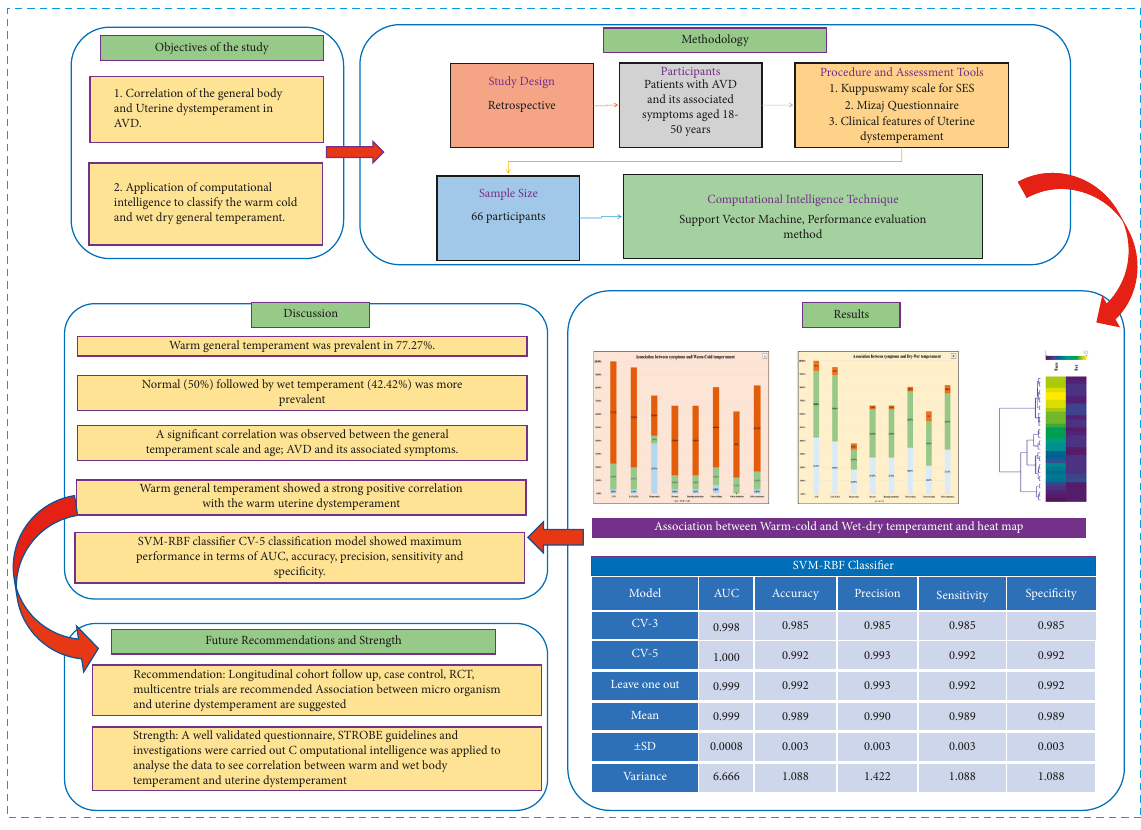
Figure 1: Schematic representation of the whole